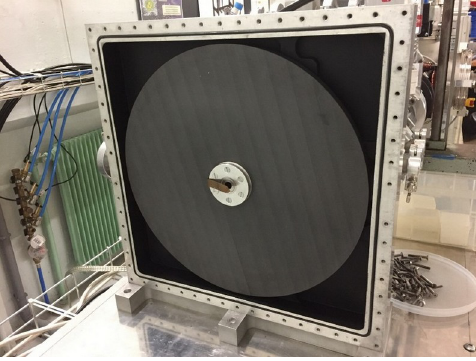
Fig. 2. Internal view of the beryllium